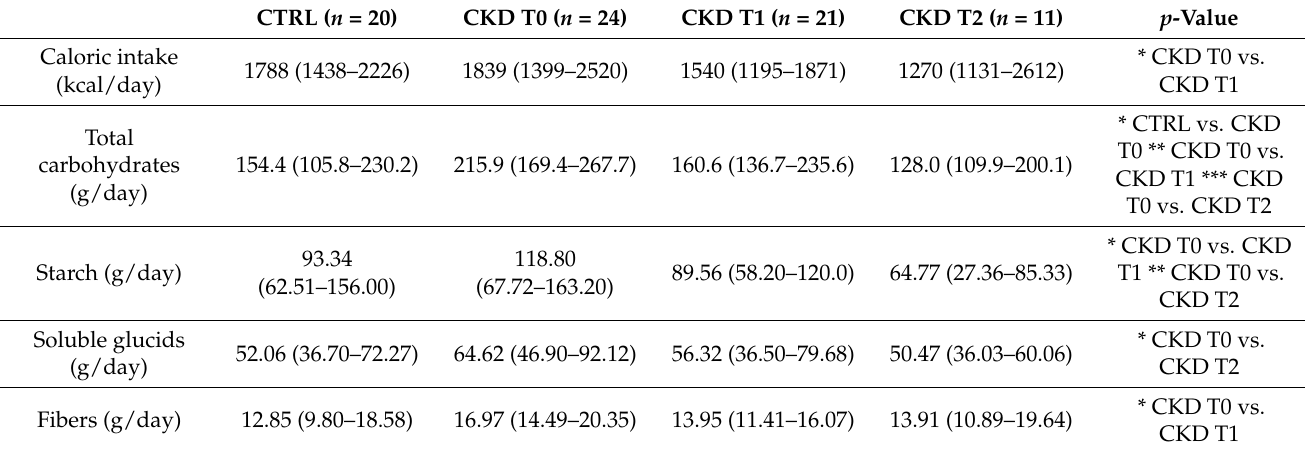
Table 2. Analysis of the differences in food consumption between the CTRL and the CKD groups and effect of the nutritional counseling on the food consumption of CKD patients. Data are reported as median